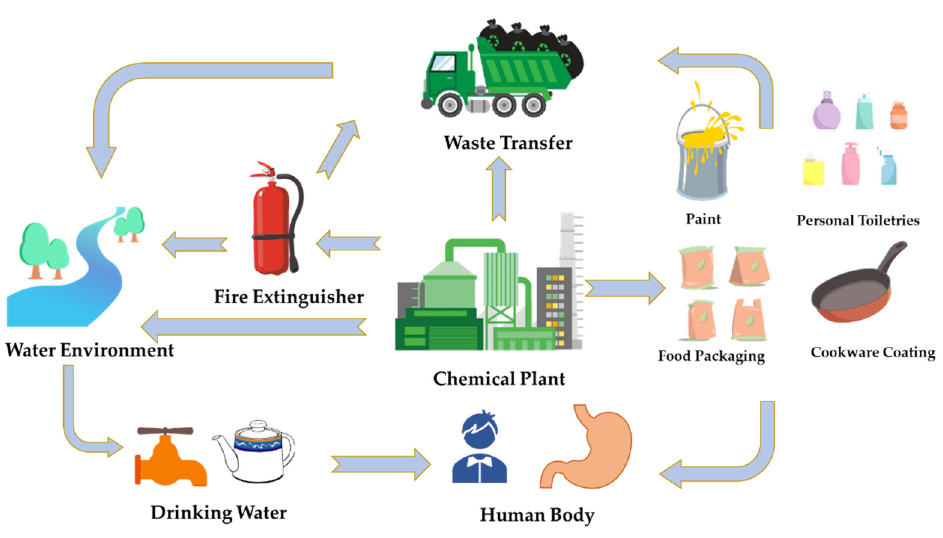
Figure 1. Migration process of PFCs in the environment.